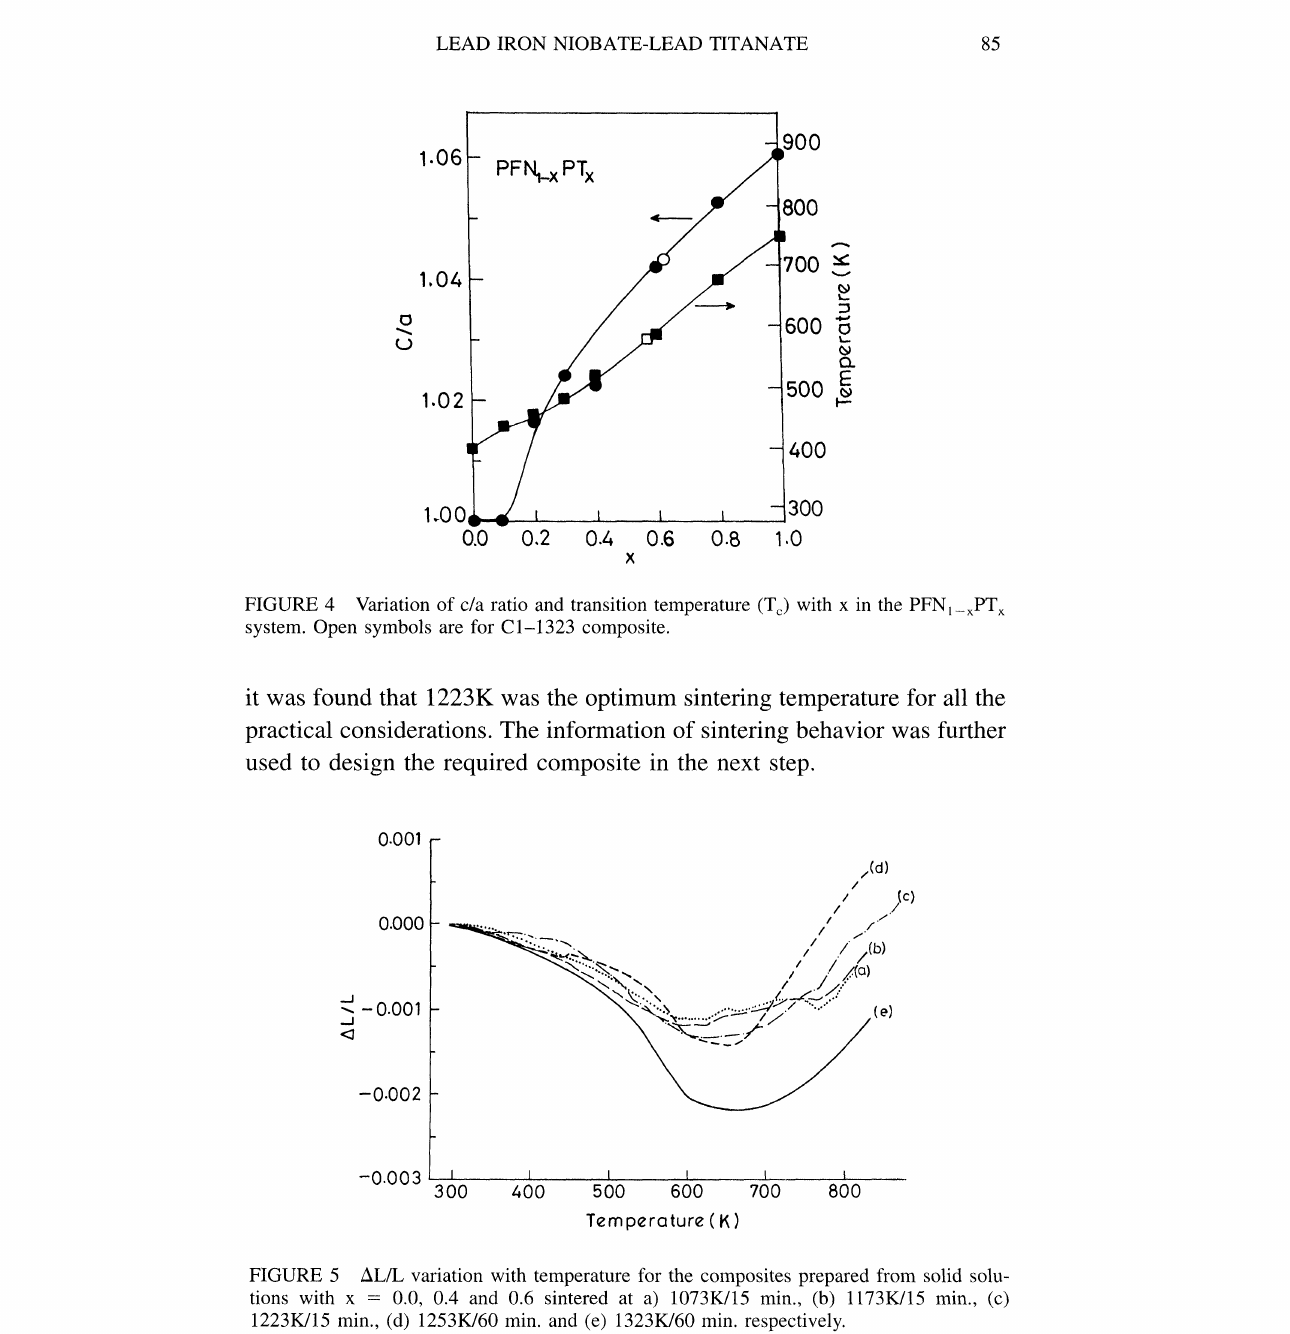
FIGURE 5 AL/L variation with temperature for the composites prepared from solid solu- tions with x 0.0, 0.4 and 0.6 sintered at a) 1073K/15 min., (b) 1173K/15 min., (c) 1223K/15 min., (d) 1253K/60 min. and (e) 1323K/60 min.